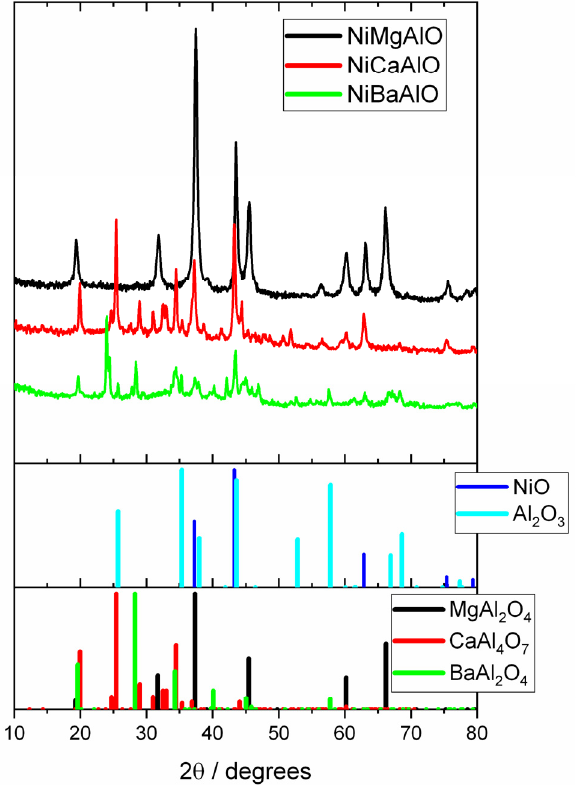
Figure 1. XRD Diffractograms of NiBaAlO, NiMgAlO, and NiCaAlO samples, where the main detected phases have been indicated (JCPDS: NiO = 01-073-1519; Al 2 O 3 = 00-042-1468, MgAl 2 O 4 = 00- 001-157, CaAl 2 O 4 =